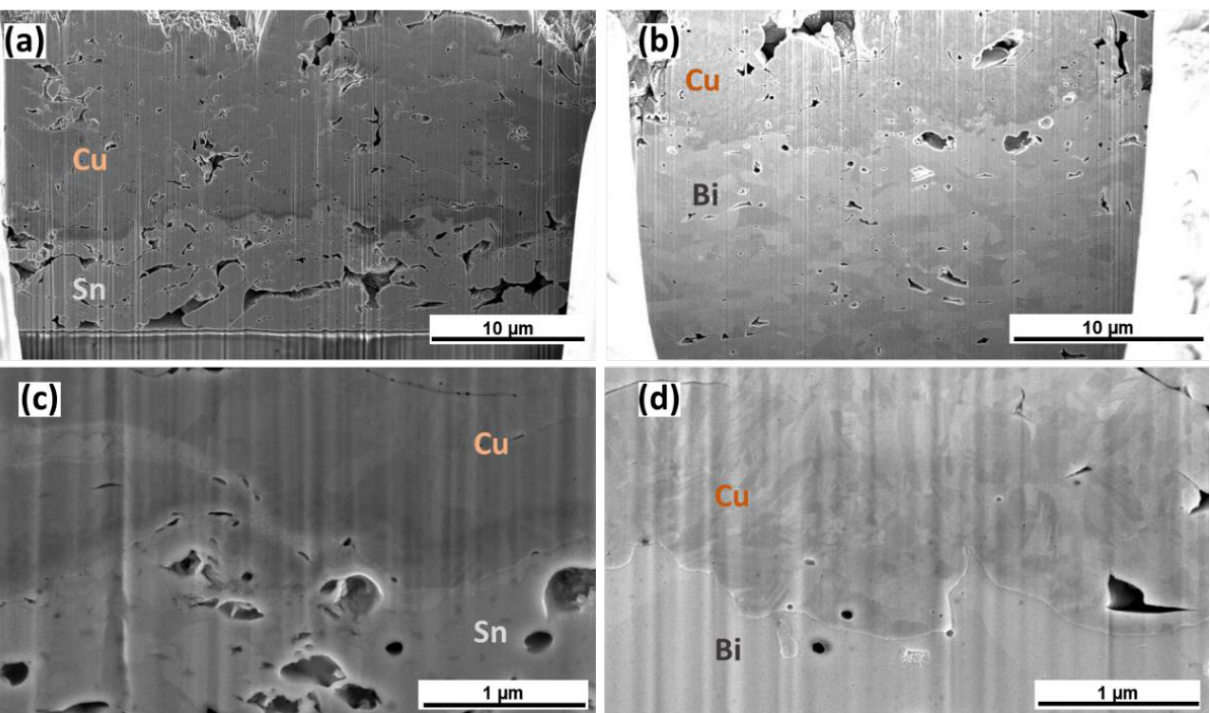
Figure 5. HR-SEM images of FIB CS of copper printing onto Sn ( a , c ) and Bi ( b , d ). ( c , d ) are magnified images of ( a , b ). High quality, compact interfaces are seen between Cu and both metals.